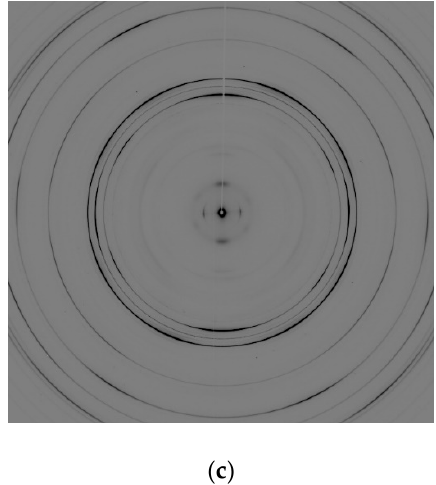
Metals 2019 , 9 , x FOR PEER REVIEW Figure 10. Synchrotron diffraction pattern recorded on the 2D flat-panel detector of the extruded GWZ831 alloy after ( a ) 0, ( b ) 4, and ( c ) 6 ECAP passes.